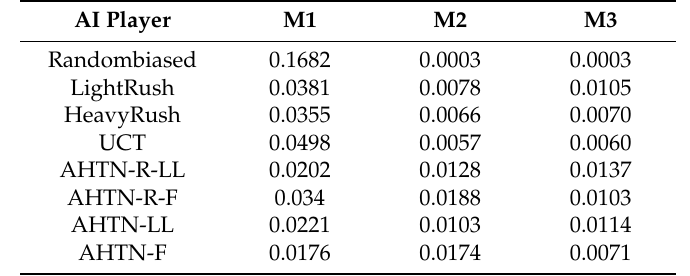
Table 2. The percentage of extra time required for repairing failed tasks and saving alternative plans relative to the total time for decision processing. The games were between AHTN-R-F and the 8 algorithms for the three map sizes. M1 AI Player M1 M2